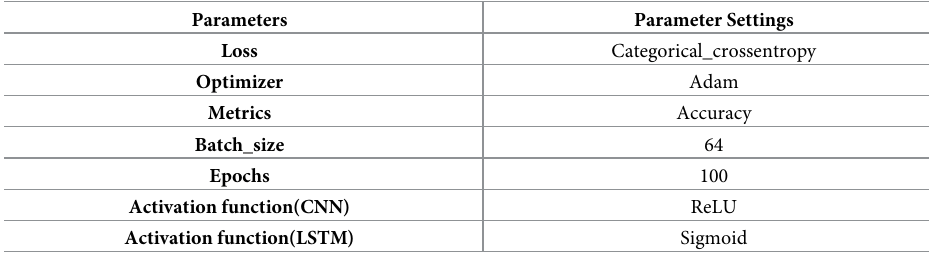
Table 4. Network training parameter.